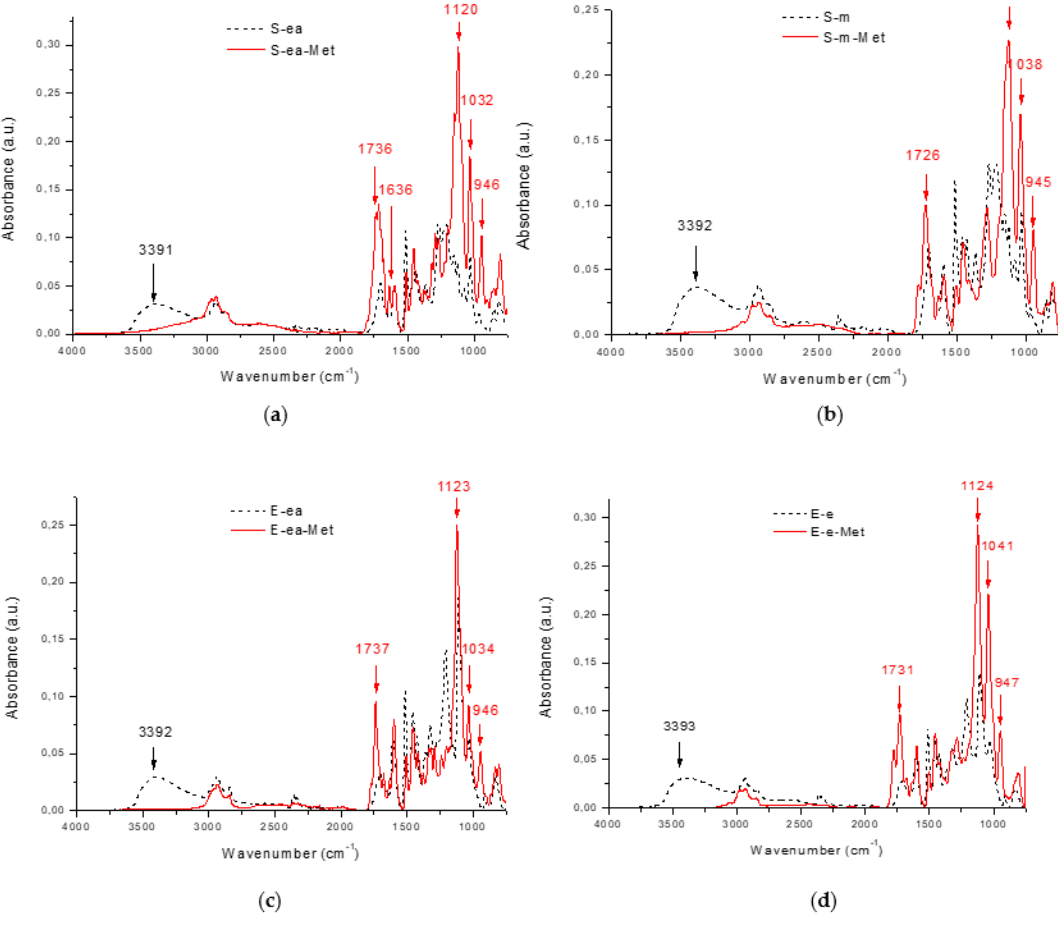
Figure 1. ATR / FTIR spectra of lignins: ( a ) SL-ea, ( b ) SL-m, ( c ) EL-ea, and ( d ) EL-e, before and after modification with methacryloyl chloride.